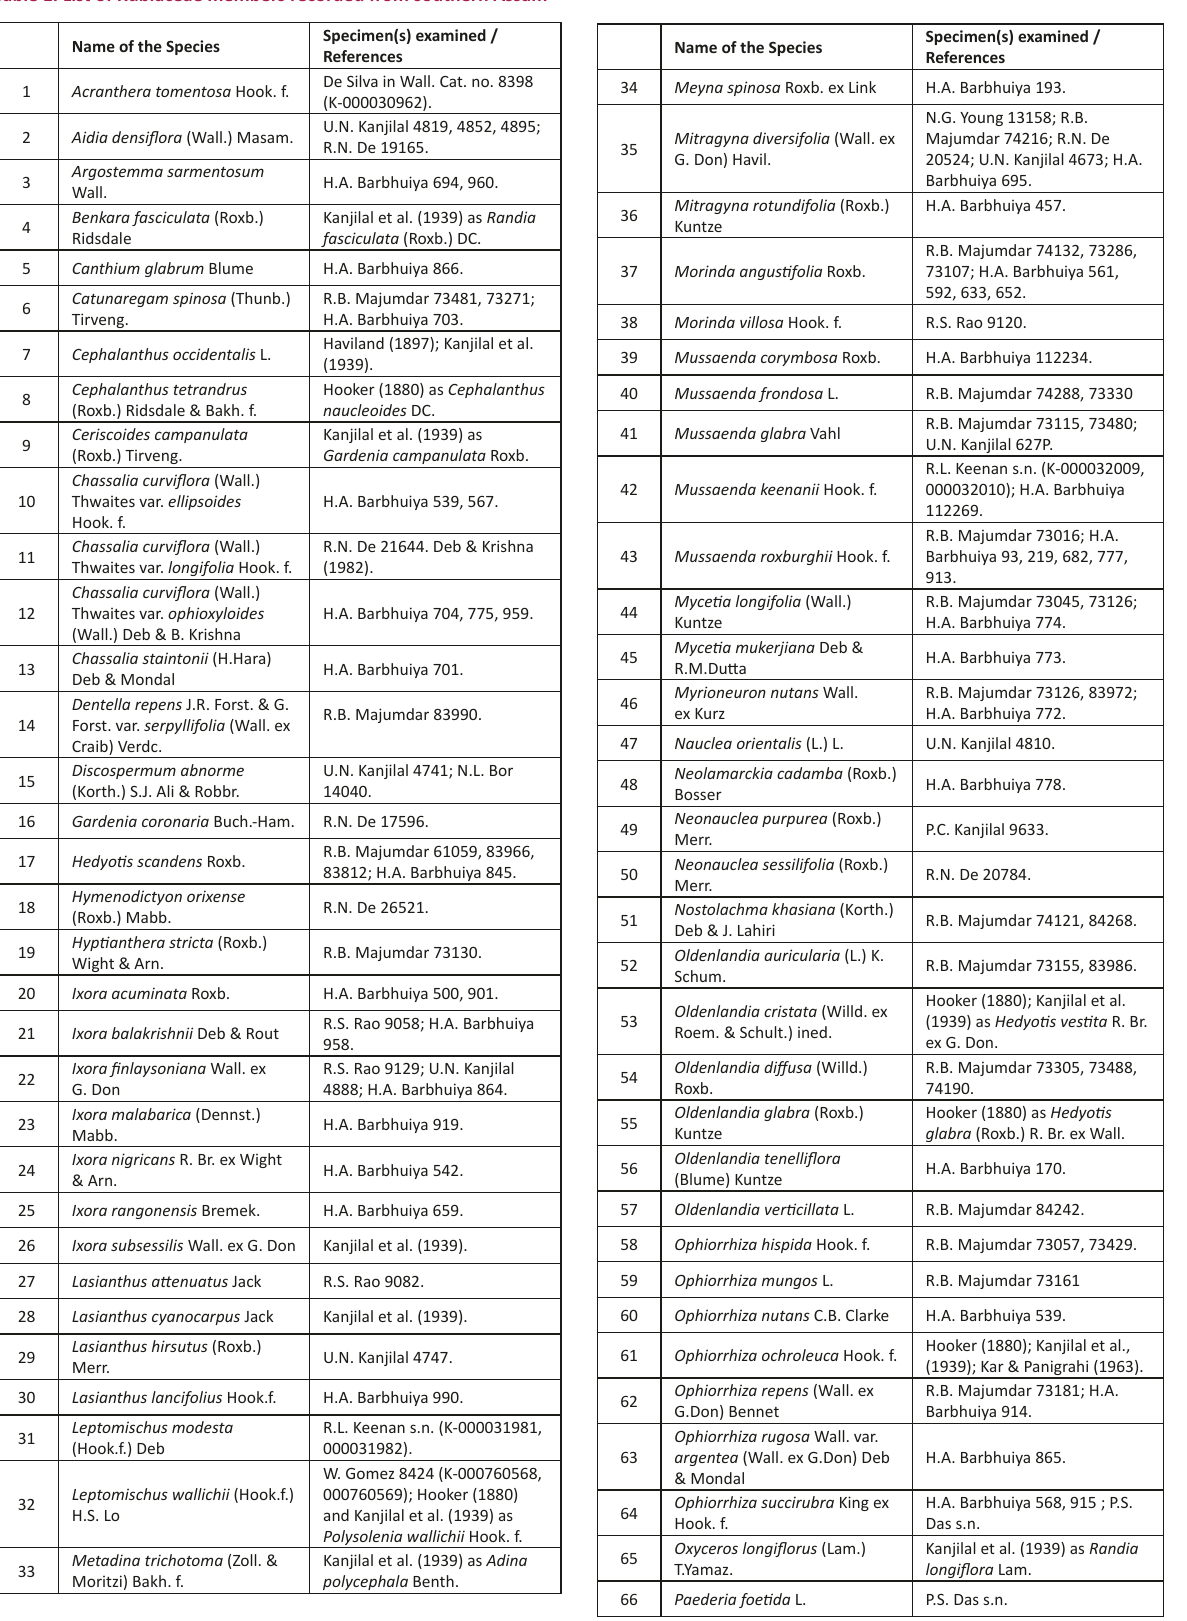
Table 1. List of Rubiaceae members recorded from southern